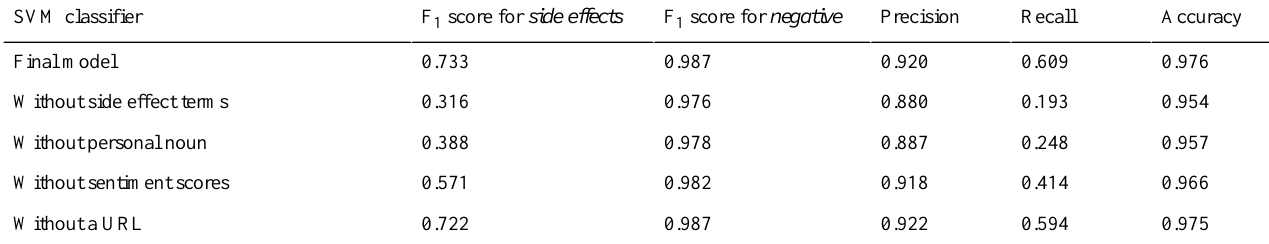
Table 3. Classification performance of support vector machine (SVM) classifier for side effects of methylphenidate.